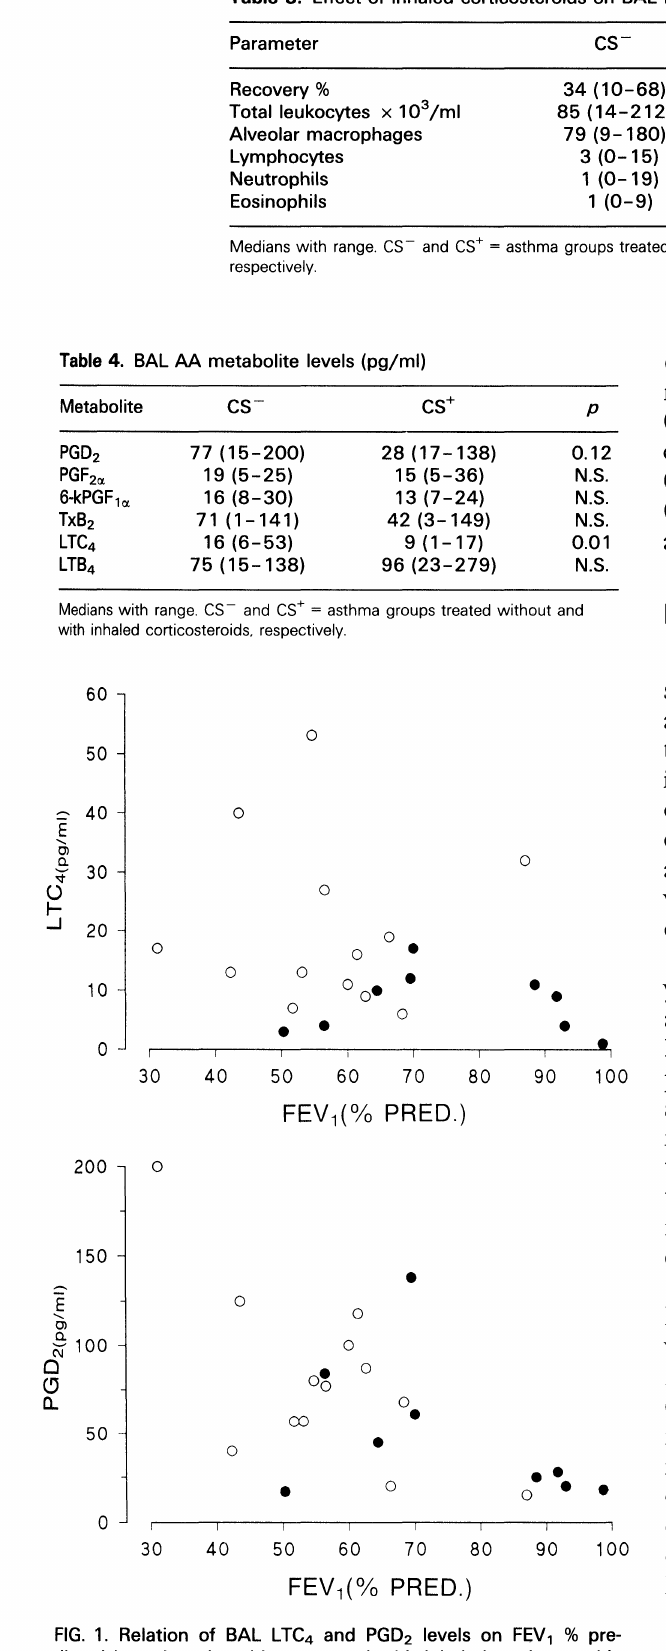
FIG. 1. Relation of BAL LTC4 and PGD2 levels on FEV1% pre- dicted in asthmatic subjects treated with inhaled corticosteroids (closed circles) and asthmatic subjects treated with inhaled 12- agonists alone (open circles). For details, see